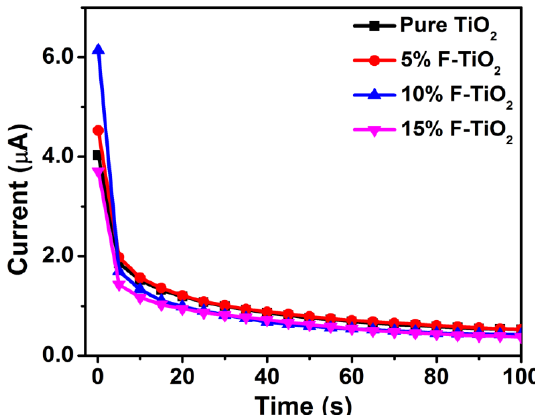
Figure 8. Dependence of stripping current of 1.0 μM Pb(II) on different desorption time for various modified GCEs.